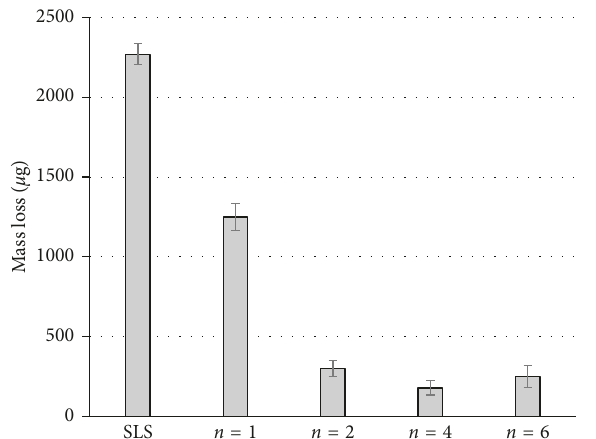
Figure 12: Wear of surfaces laser-processed 1, 2, 4, and 6 times (2.5mm/s; 2.5W). SLS: as-manufactured SLS sample.